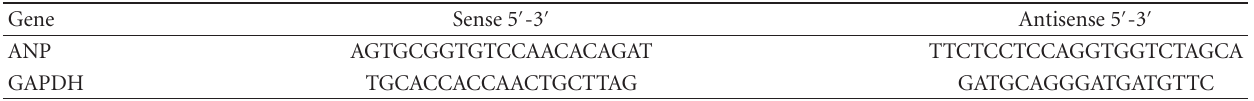
Table 1: Primers for real-time